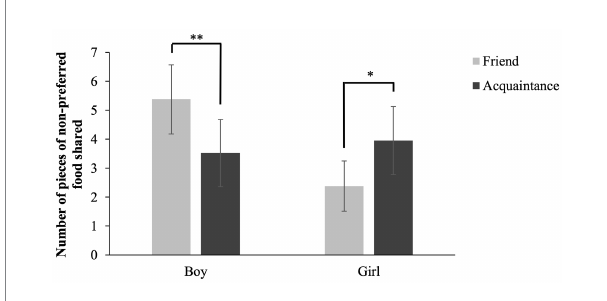
FIGURE 1 Interaction between number of pieces of non-preferred food shared and sex. Error bars represent 95% confidence intervals. * p <0.05, ** p